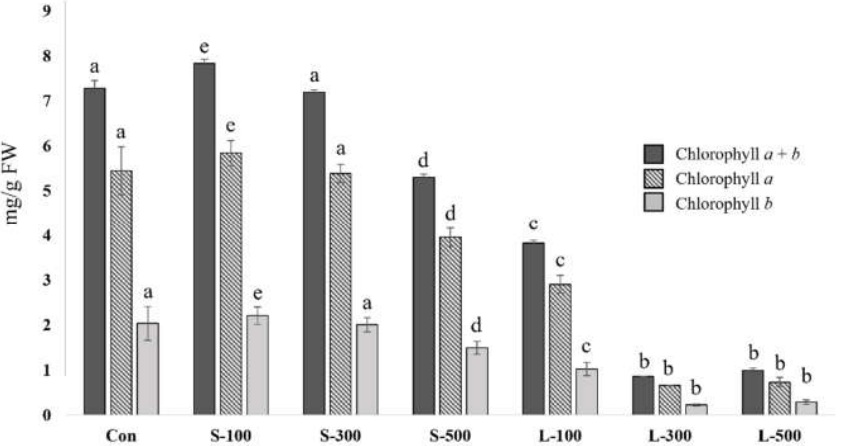
Figure 4. Determination of total chlorophyll, chlorophyll a , and chlorophyll b contents upon gamma irradiation. Each bar represents the mean ± SD ( n = 3). Values with different letters are significantly different using Duncan’s multiple range test ( p < 0.05).